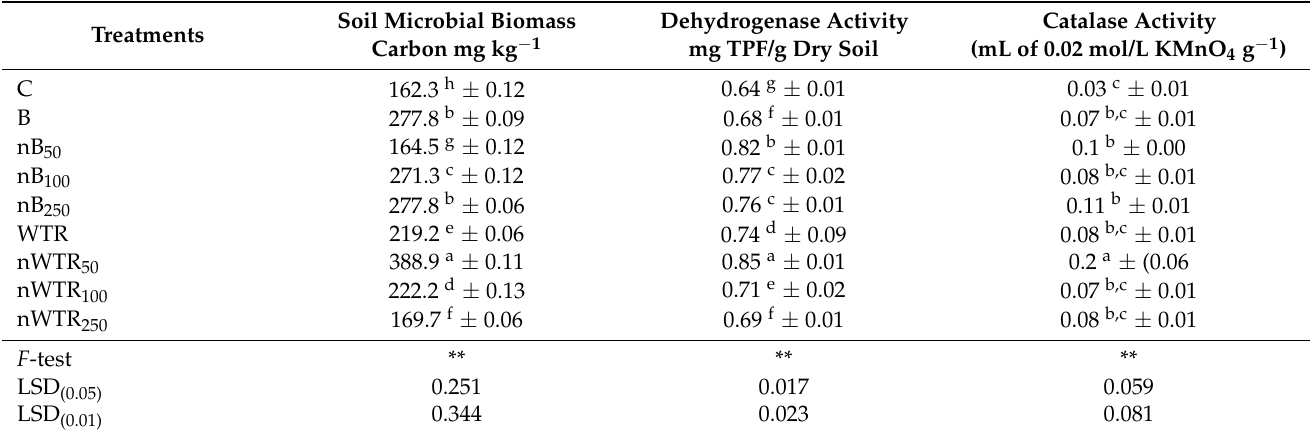
Table 2. Effect of nanoparticles of biochar (nB) and water treatment residuals (nWTR) on soil microbial biomass carbon and enzymes